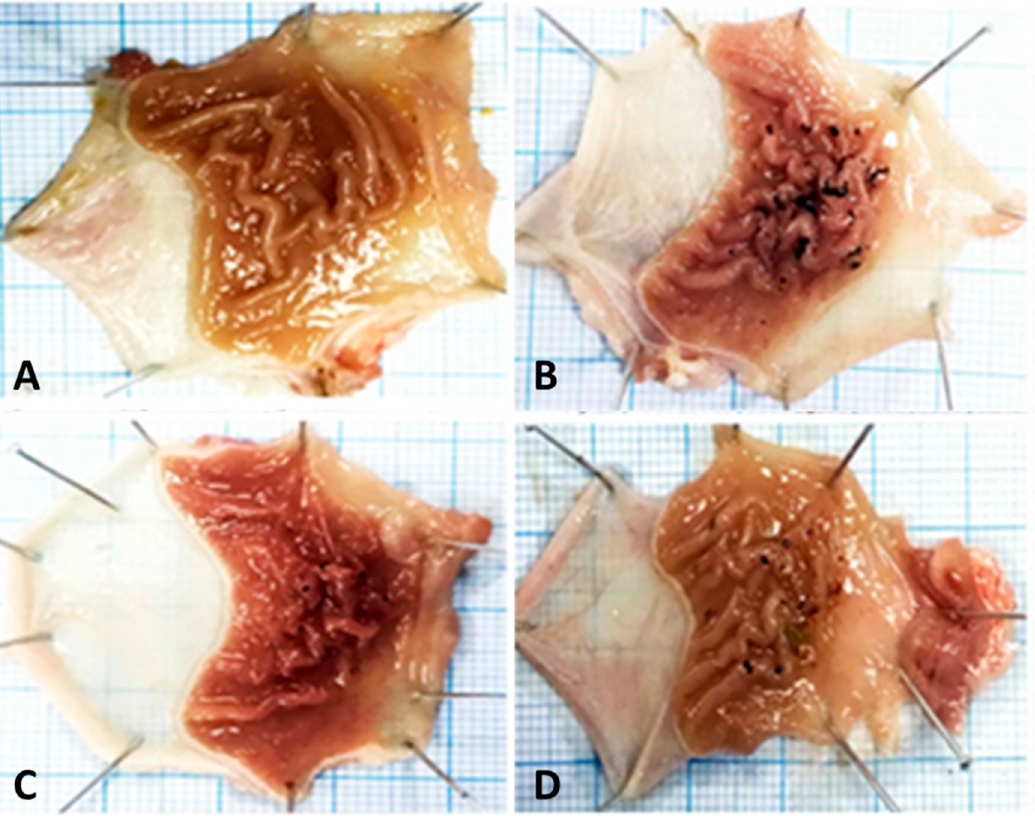
Figure 2. Photomicrograph showing the effect of CA on the gross morphology of the gastric mucosa of ulcerated rats. ( A ) Negative control group showed no injury of the gastric mucosa ( B ) IND- ulcerated rats ( C ) IND- treated rats pretreated with ESP (IND + ESP) (20 mg/kg) ( D ) IND- treated rats pretreated with (IND + CA) 100 mg/mL; IND: Indomethacin, ESP: Esomeprazole, CA: Carnosic acid. Table 1. Effects of CA on IND-induced macroscopic gastric injuries. Ulcer Score, Ulcer Index and Effect of Carnosic acid (Preventive Index).